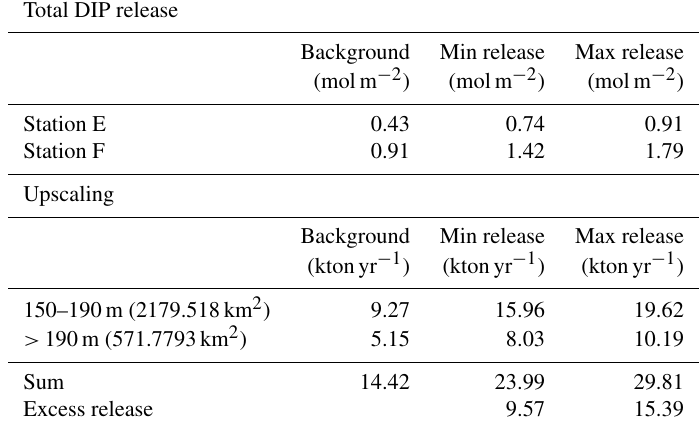
Table E1. Total release of dissolved inorganic phosphorus (DIP). The total DIP release represents the entire time period from the arrival of oxygen until the end of the study (3.13 years). The total DIP release was not calculated for station D since no flux measurements were conducted at the site in